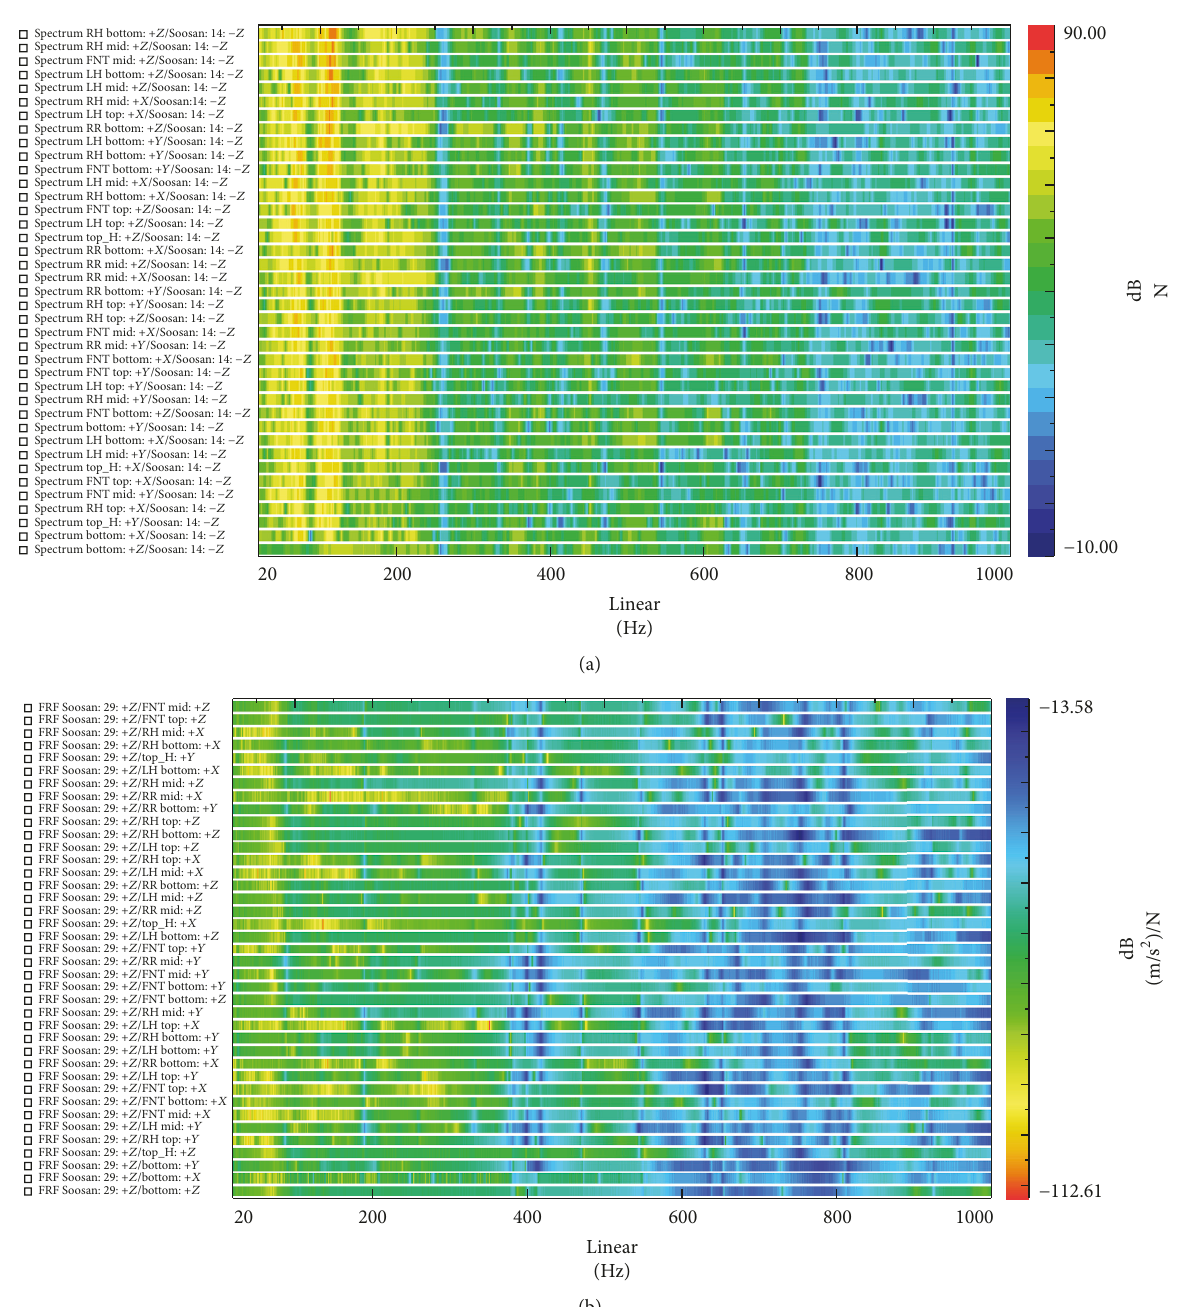
Figure 11: Analysis results of impact load in the frequency domain: (a) contribution of the impact loads delivered to the housing through each isolation pad, (b) vibration transfer function (VTF)